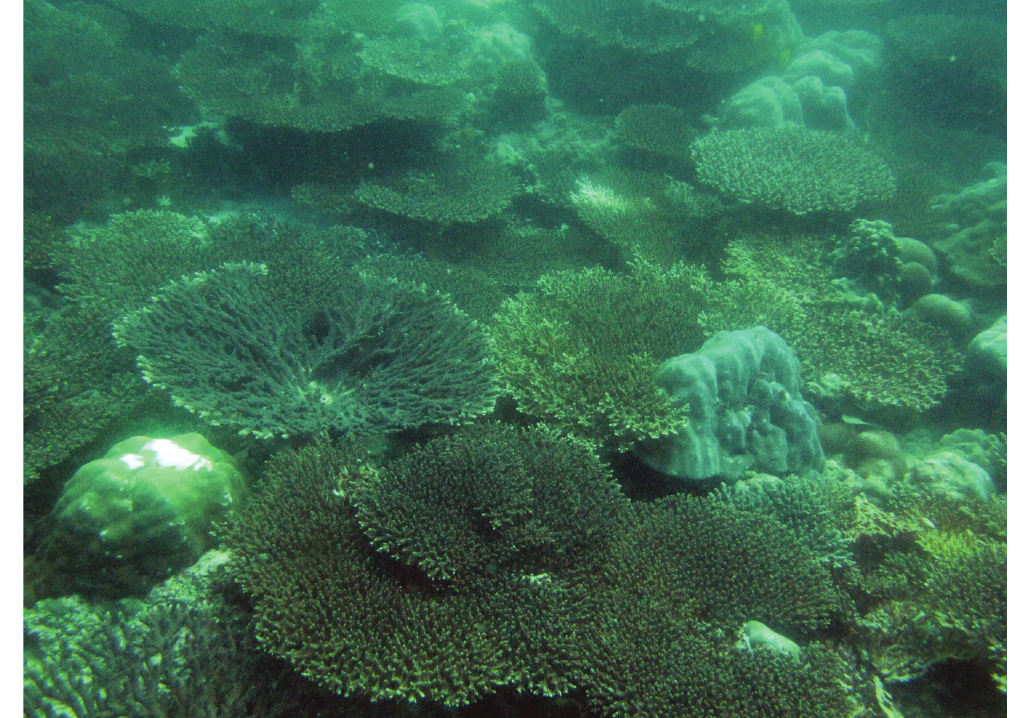
Figure 1. The island of Socotra supports diverse assemblages of Acropora